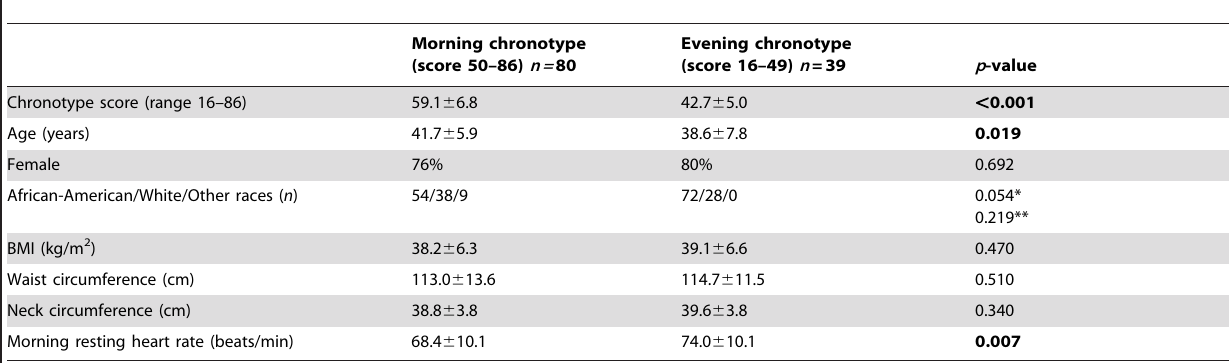
Table 1. Demographic and anthropometric characteristics of study participants.